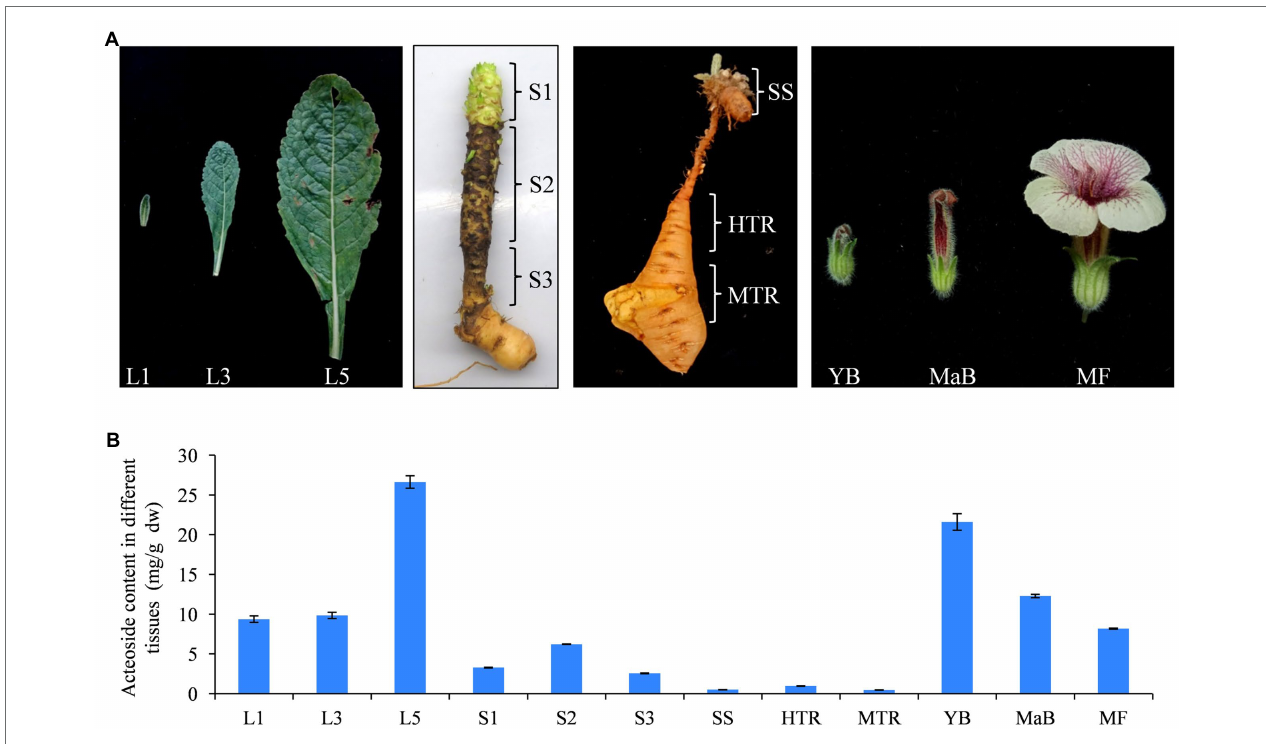
FIGURE 6 | Acteoside content in different tissues of R. glutinosa . (A) Characteristics of the 12 tissues of R. glutinosa . (B) Acteoside content in 12 tissues of R. glutinosa plants. L1, tender leaf; L3, fully expanded leaf; L5, old leaf; S1, top of stem; S2, middle piece of stem; S3, lower stem; SS, seed stock; HTR, the head of tuberous root; MTR, the middle of tuberous root; YB, Young flower bud; MaB; mature flower bud; and MF, newly opened